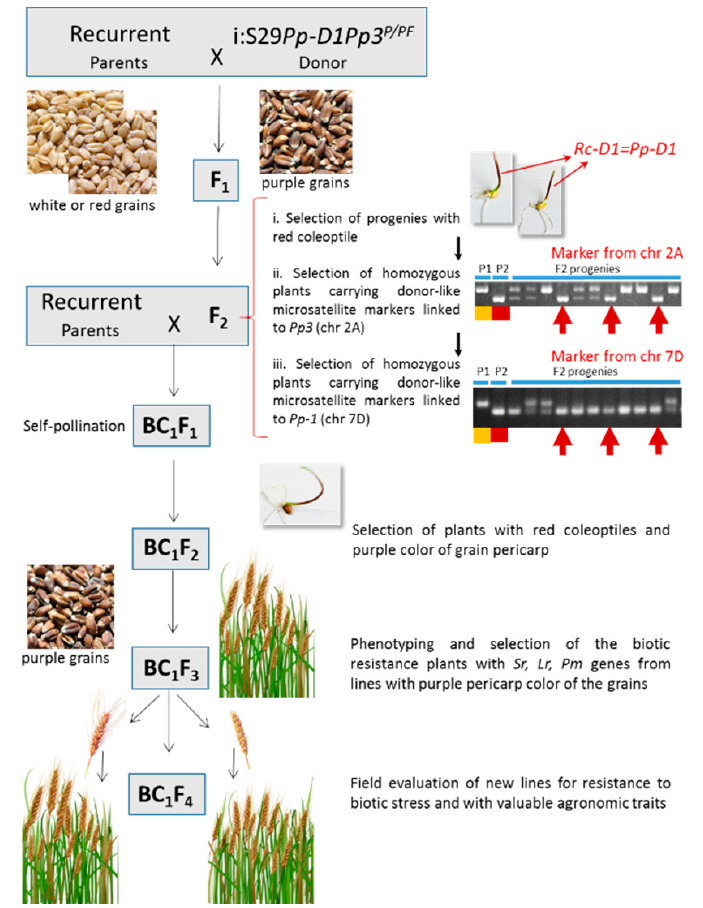
Figure 1. Breeding strategy for development of anthocyanin-rich cultivars of bread wheat ( Triticum aestivum L.) based on the elite spring wheat cultivars and promising breeding lines. The near ‐ isogenic line i:S29 PpD1Pp3 PF with cv Purple Feed (PF) introgressions in chromosomes 2A and 7D, carrying,